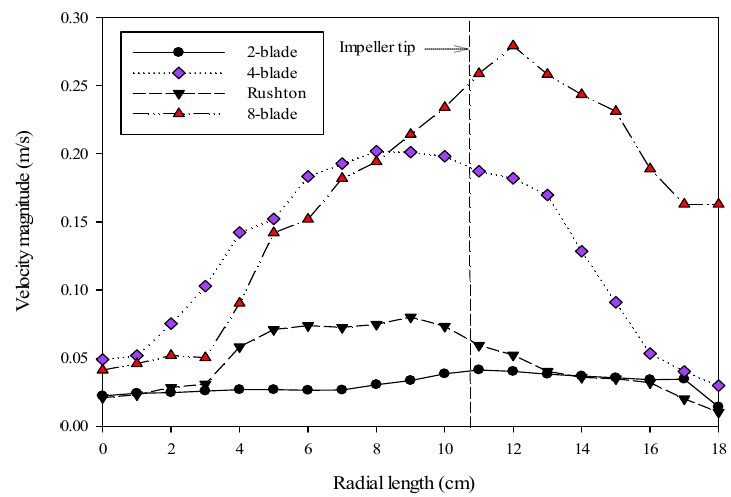
Figure 4. Isosurface comparing water interfaces for four different impellers including ( a ) a three - blade turbine, ( b ) a four - blade turbine, ( c ) a Rushton turbine, and ( d ) an eight - blade turbine .